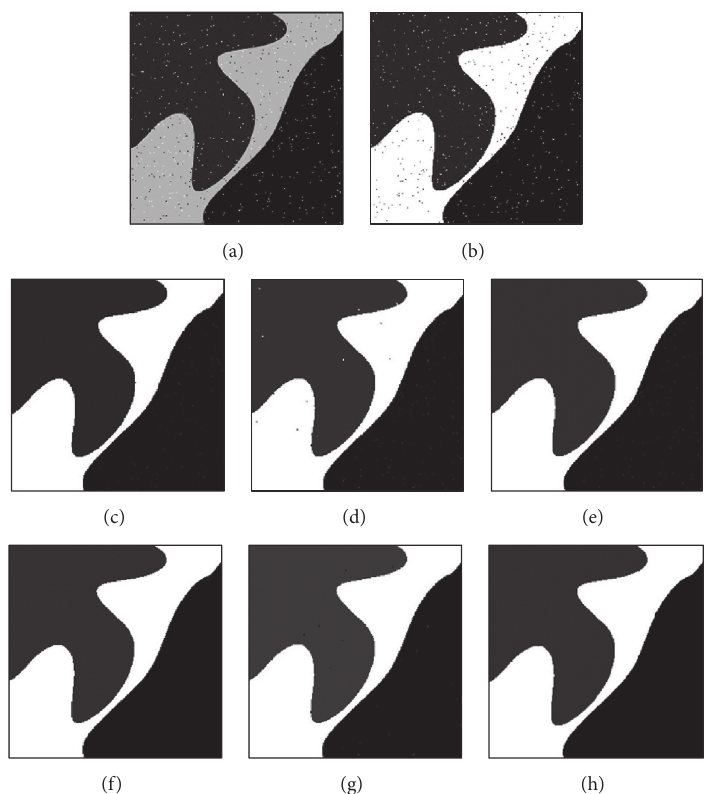
Figure 3: Segmentation results on synthetic image. (a) Original image corrupted by 15% of Salt and Pepper noise. (b) FCM result. (c) FCM S